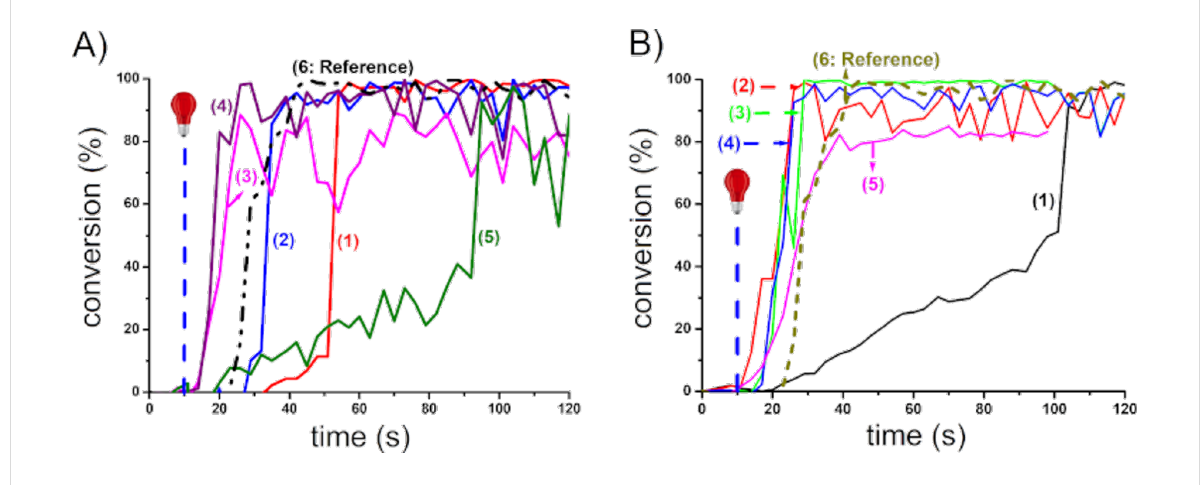
Figure 2: Photopolymerization profiles of PETIA monomer under air (acrylate functions conversion vs irradiation time) in the presence of a NIR dye/ iod/NPG 0.1:3:2. %w/w/w system. A) NIR dyes with BPh 4 − and Na + as counter anion and counter cation: (1) Ca , (2) Cb , (3) CBPh1 , (4) CBPh4 ,